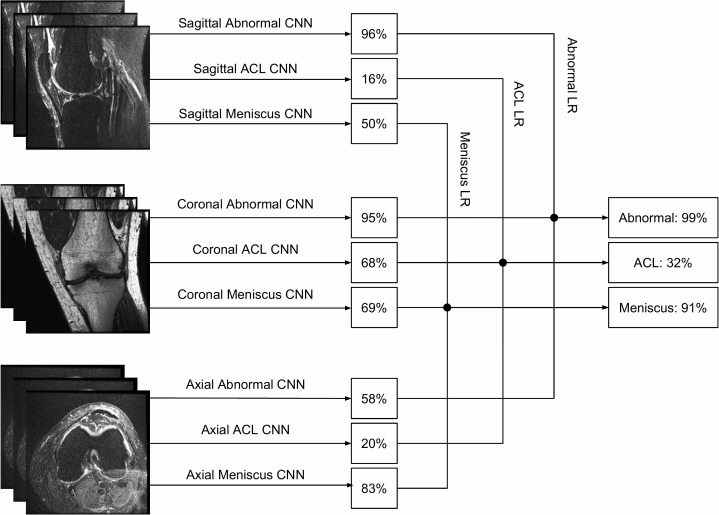
Combining series predictions using logistic regression.Each examination contains 3 types of series: sagittal, coronal, and axial. For each task (abnormality, ACL tear, meniscal tear), we trained a logistic regression classifier to combine the 3 probabilities output by the MRNets to produce a single predicted probability for the exam. The predicted probabilities from an exam in the internal validation set are shown as an example.ACL, anterior cruciate ligament; CNN, convolutional neural network; LR, logistic regression.